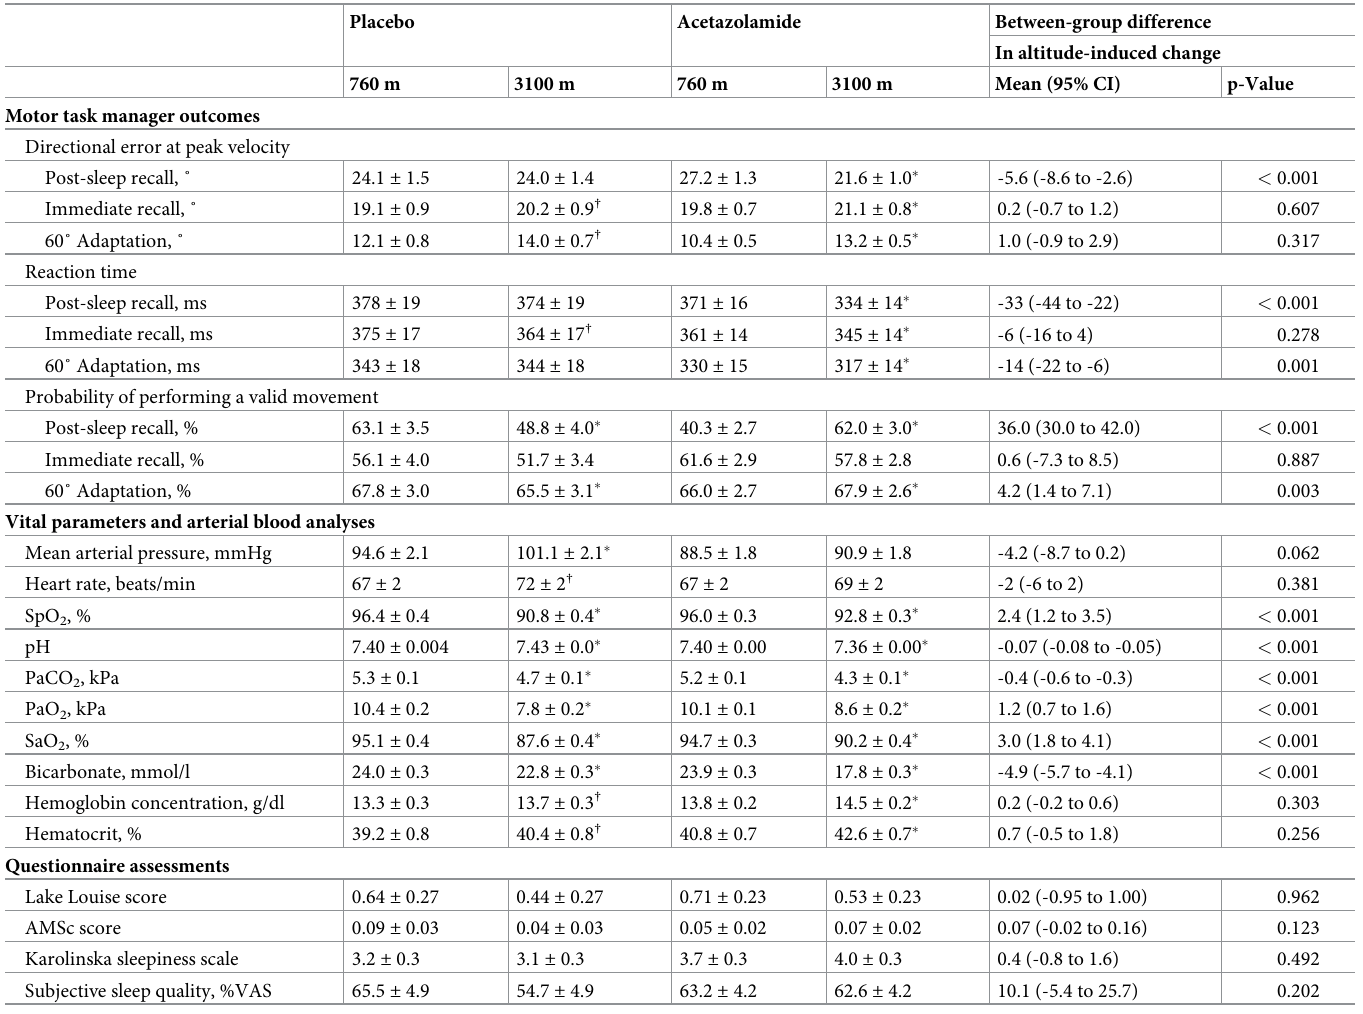
Table 2. Outcomes at low and high altitude (760 m and 3100 m). Placebo Acetazolamide Between-group